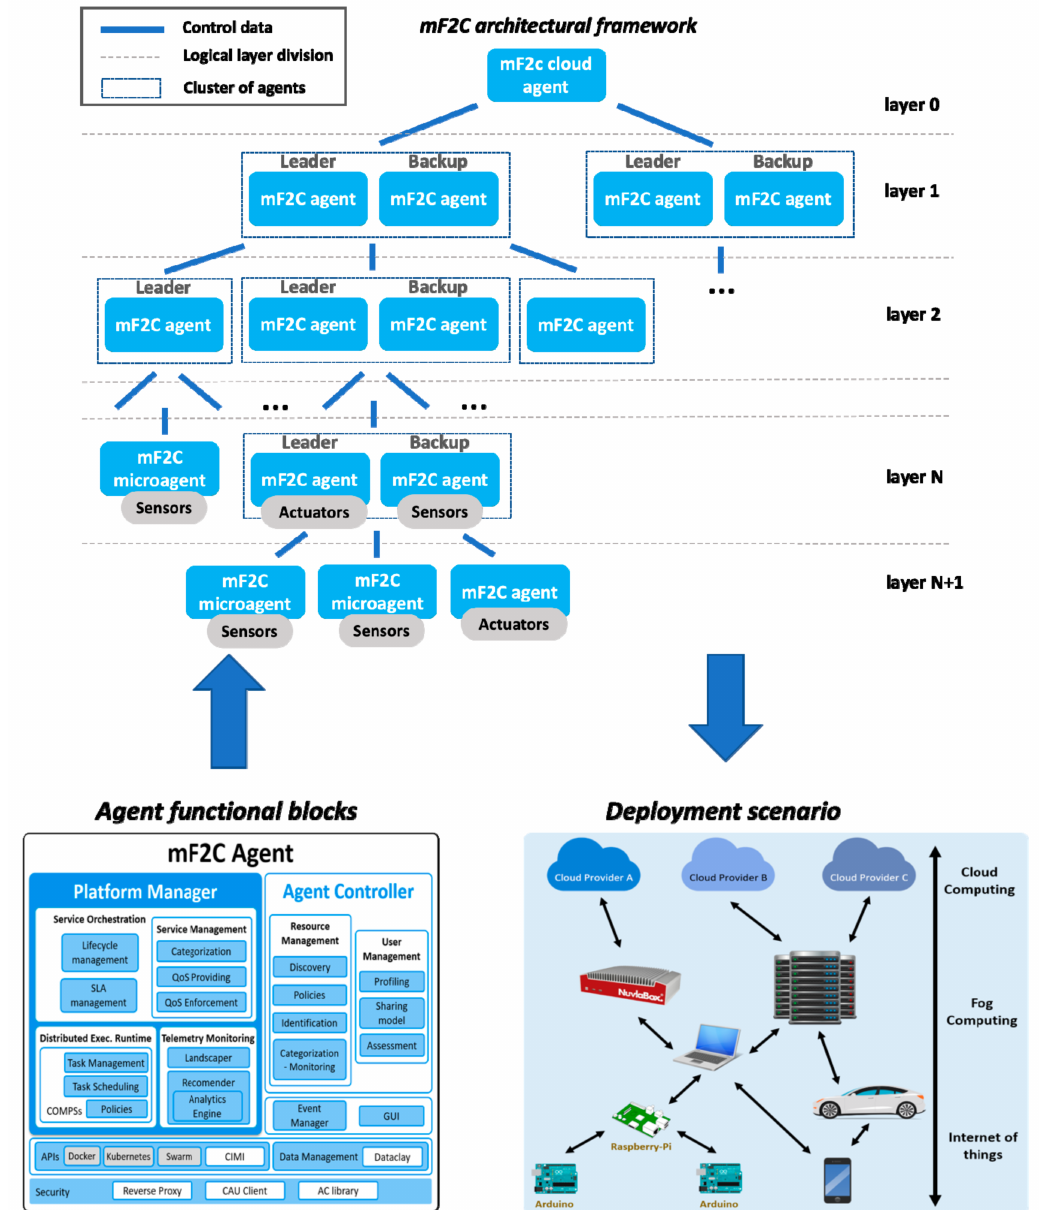
Figure 1. mF2C layered architecture, agents blocks and envisioned cloud continuum